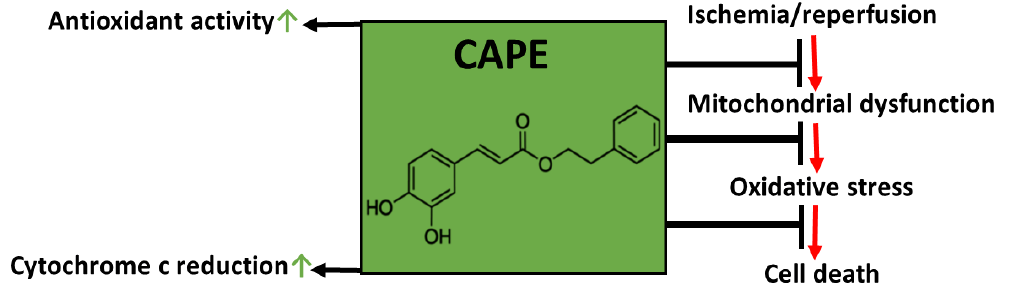
Figure 12. Schematic illustration of our hypothesis.